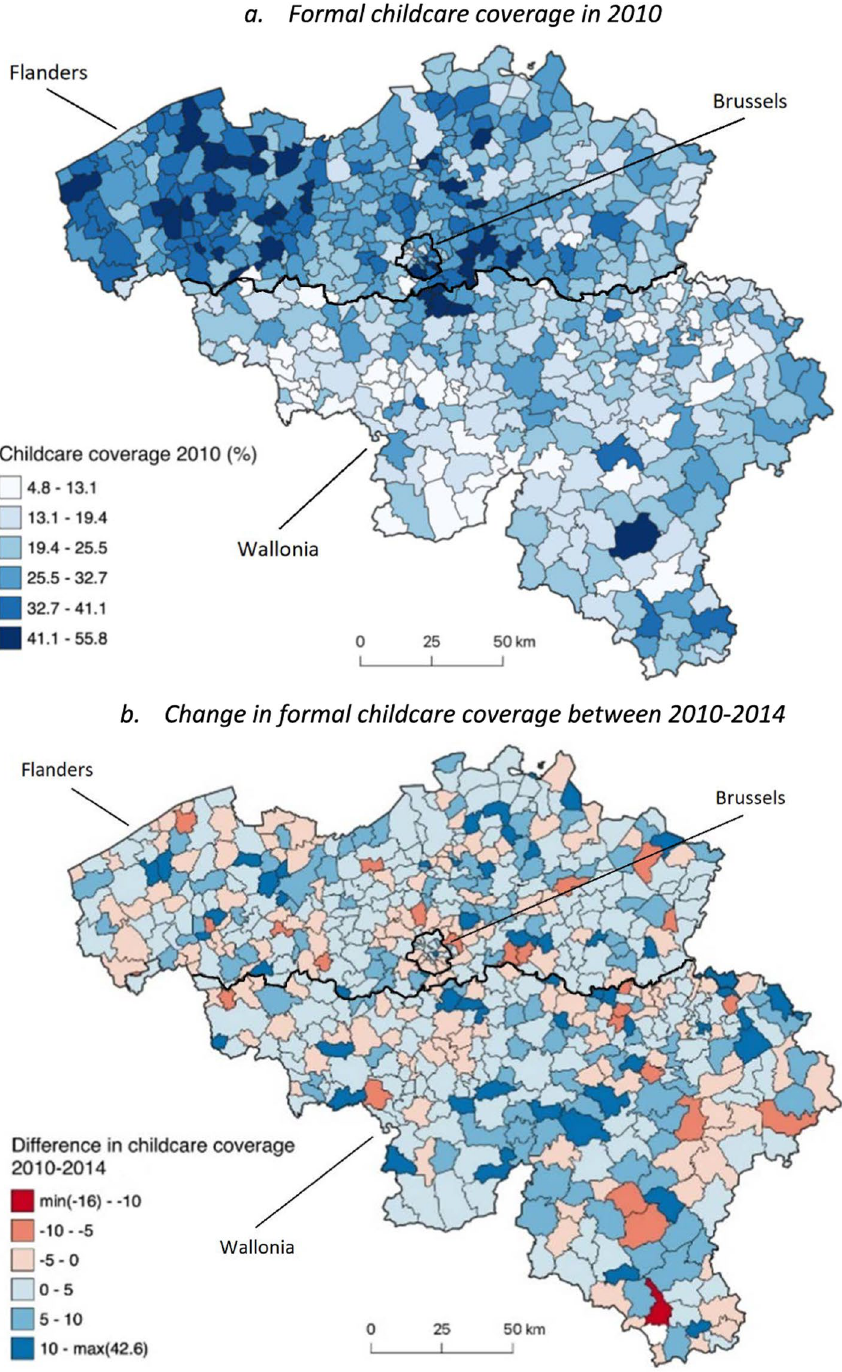
Fig. 1 a Formal childcare coverage in 2010 and b change in formal childcare coverage between 2010 and 2014 in Belgian municipalities. Childcare coverage reflects the number of formal childcare places per 100 children aged 0–3 in each municipality. The maps show (changes in) childcare coverage for all municipalities separately (Source: K&G and ONE, calculations by